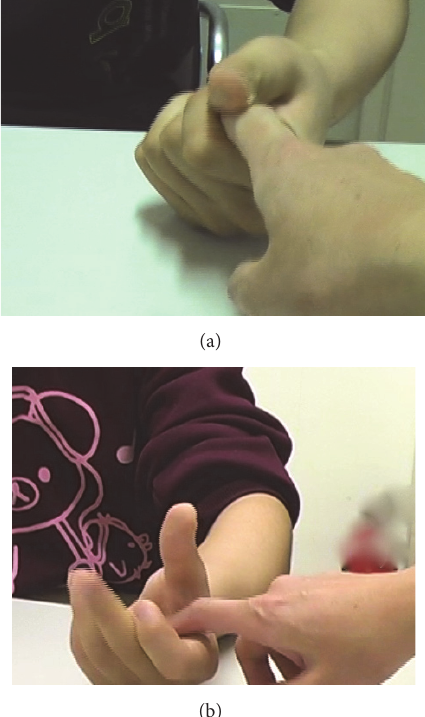
Figure 2: Improvement of the patient’s grasp reflex. (a) The patient couldnotopenhishandwhentheexaminerinsertedhisindexfinger into the patient’s palm before BTX-A treatment. (b) The patient couldopenhishandwhentheexaminerelicitedthegraspreflexafter BTX-A